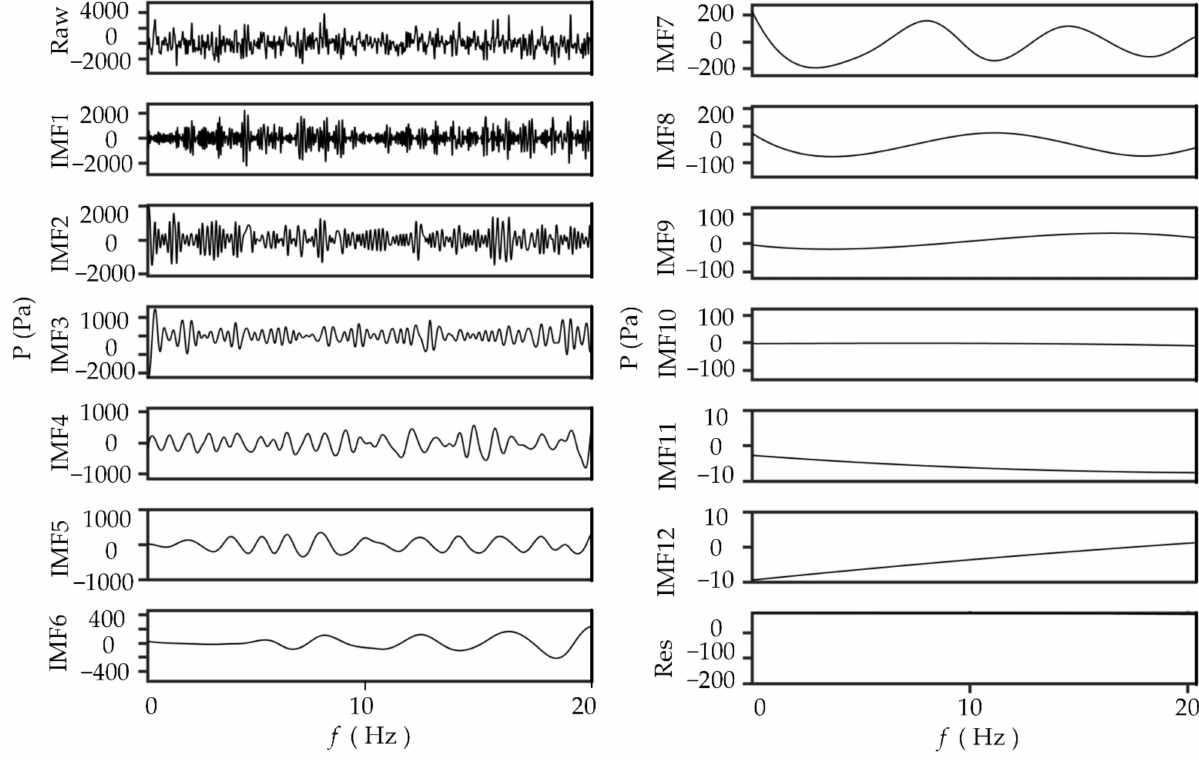
Figure 6. EEMD decomposition results.